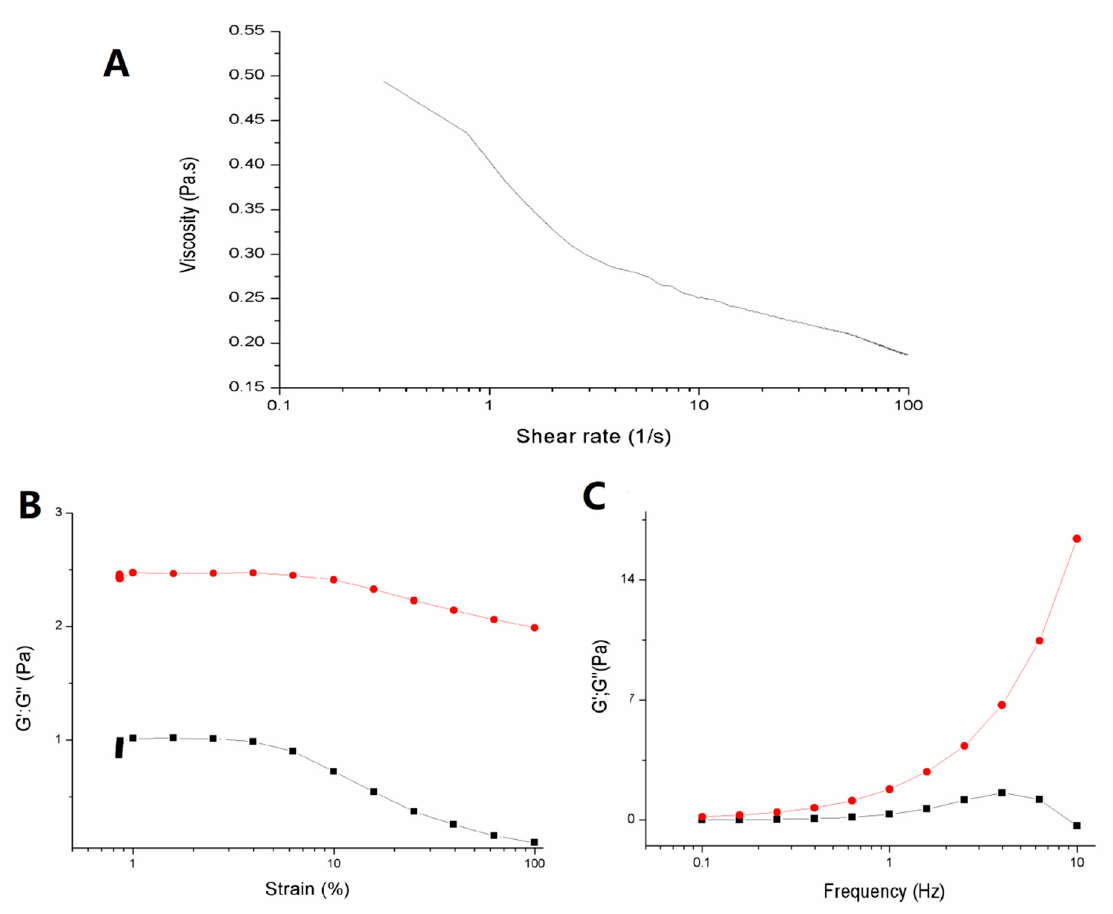
Figure 3. Rheological analysis of ZJRP (obtained through optimized conditions). ( A ) The flow behavior of ZJRP. ( B , C ) Storage modulus (G’) and loss modulus (G”) of ZJRP ( B , strain sweeps at 0.1 S − 1 frequency of modulus. C , frequency sweeps at 1% strain.). The black squares represent the storage modulus (G’) and the red dots mean the loss modulus (G’’).